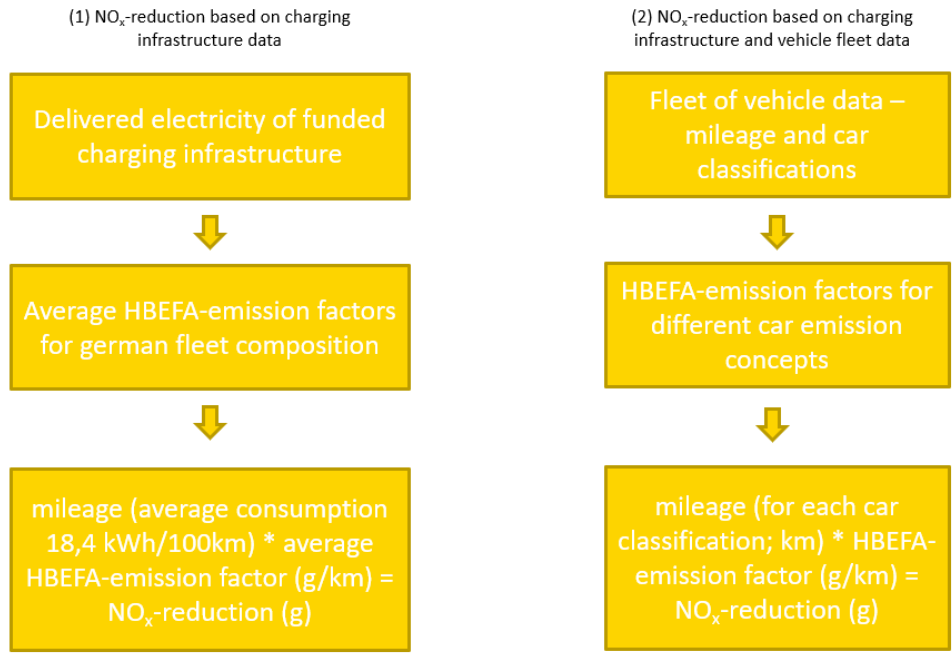
Figure 2. Research concept of LINOx BW for classifying the impact of charging infrastructure on local emissions of nitrogen oxides . Table 1. Passenger car emission concepts and HBEFA emission factors.